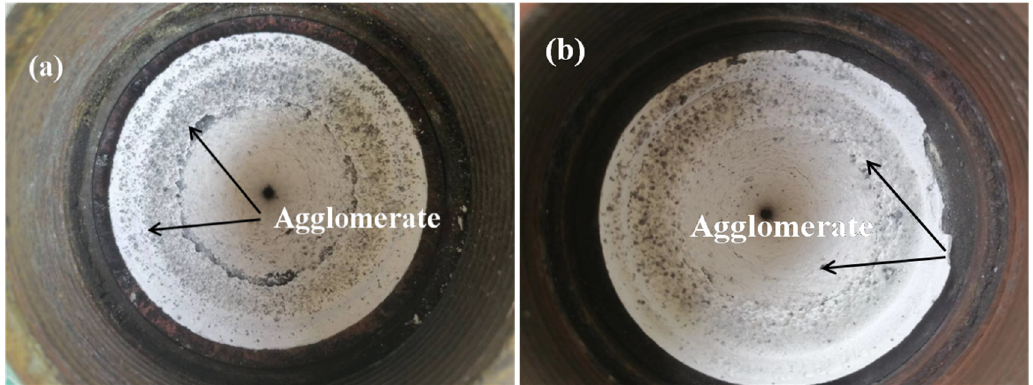
Figure 5. Propellant combustion residue deposit at nozzle of 75 mm simulated test solid rocket motor: ( a ) Al–2.5Li/AP/RDX/HTPB propellant (HA-5); ( b ) Al/AP/RDX/HTPB propellant (HA-1).